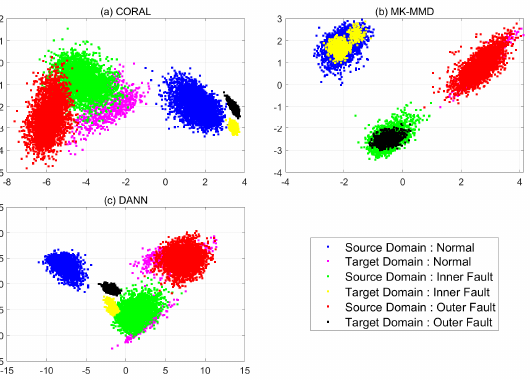
Figure 12. PCA results of case 2: ( a ) CORAL ( b ) MK-MMD ( c ) DANN.